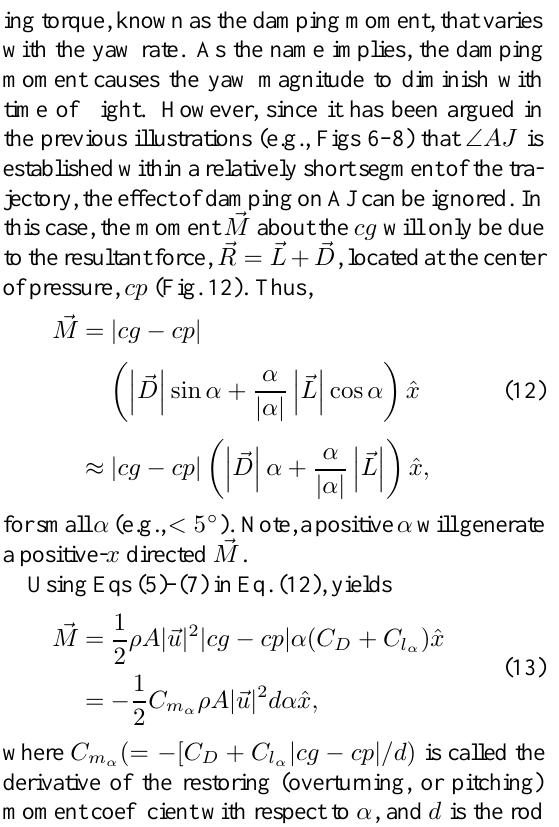
Fig. 13. Swerve-fixed ( ˆ s, ˆ Y ) and earth-fixed ( ˆ z, ˆ y ) coordinate system (illustrated dimensions are not to